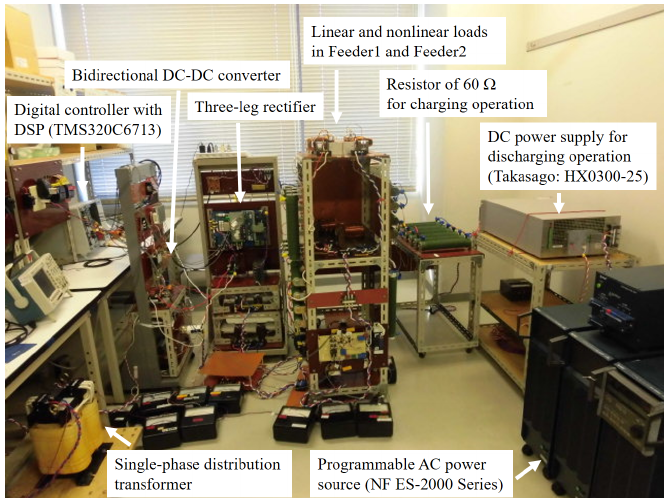
Figure 6. Real picture for constructed experimental setup of Figure 5. Table 3. Test data for single-phase distribution transformer in Figure 1 on PSIM